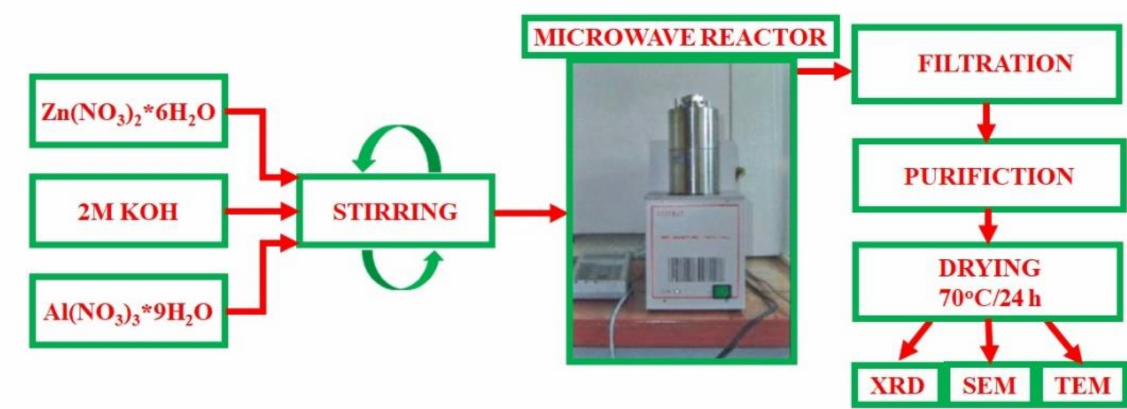
Figure 1. Scheme of the production of zinc-aluminum